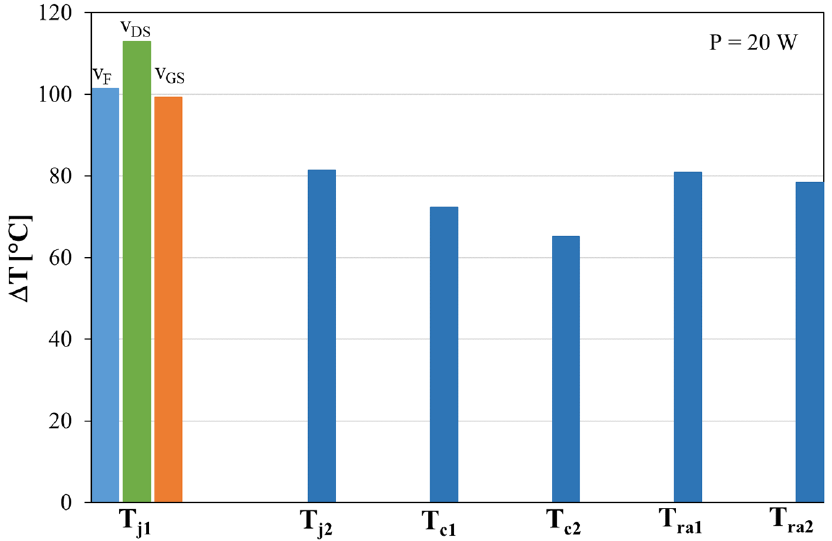
Figure 16. Temperature excesses over the ambient temperature measured in selected points of the tested device by the electrical, contact, and optical methods.